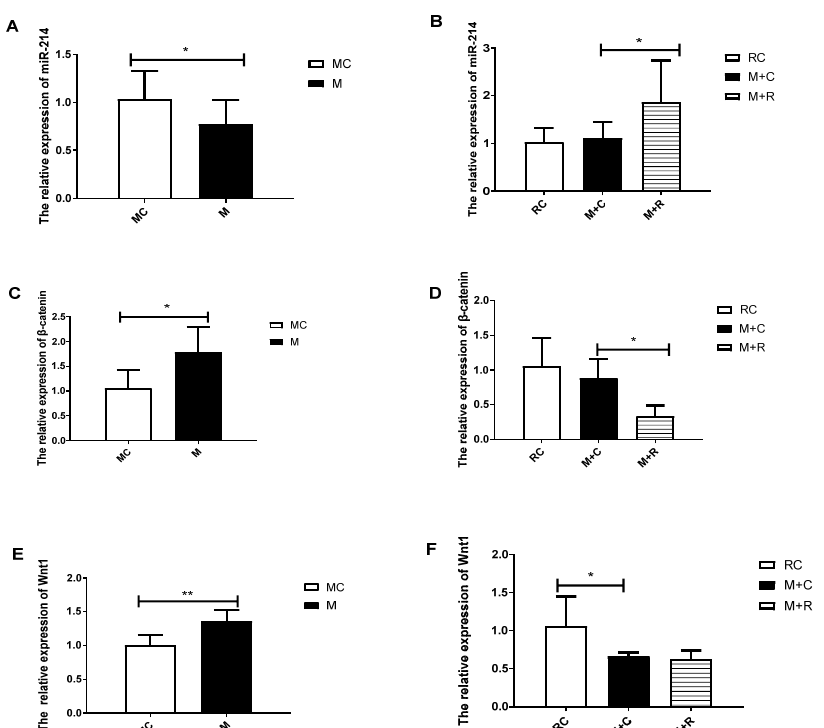
Figure 5. The expression of mouse cartilage miR-214 and its related downstream genes. ( A , B ) the expression of miR-214; ( C , D ) the expression of Wnt1 mRNA; ( E , F ) the expression of β -catenin mRNA. (n = 8, * p < 0.05, ** p < 0.01.)